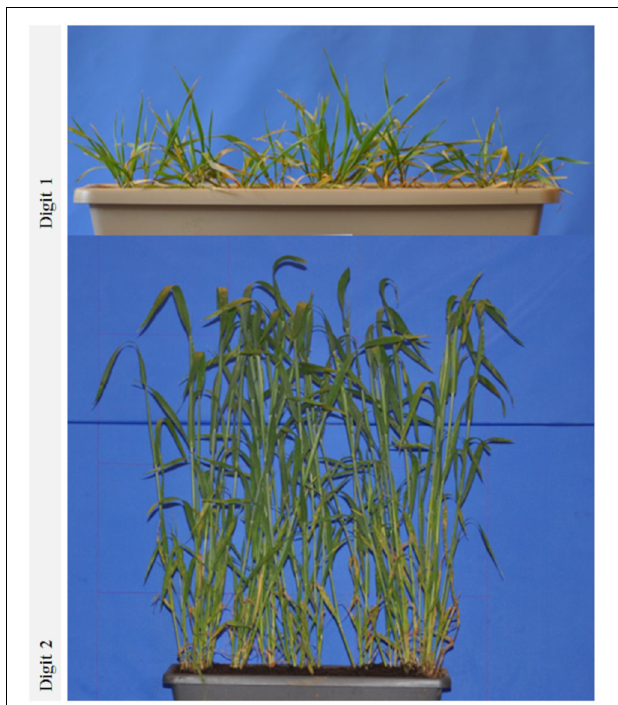
FIGURE 2 | Photographs of segments of rows analyzed. Rows were collected from the field at 722 ◦ Cd (top) and 1272 ◦ Cd (bottom) and transplanted in pots to be digitalized in the laboratory. The treatment shown here is